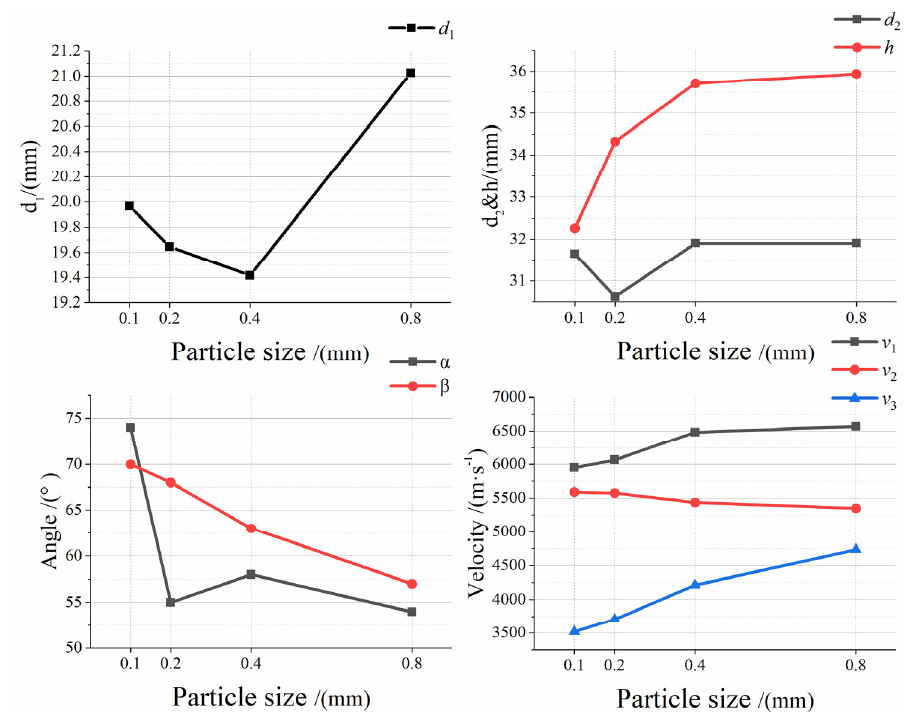
Figure 8. Curves of characteristic parameter values under different particle sizes.